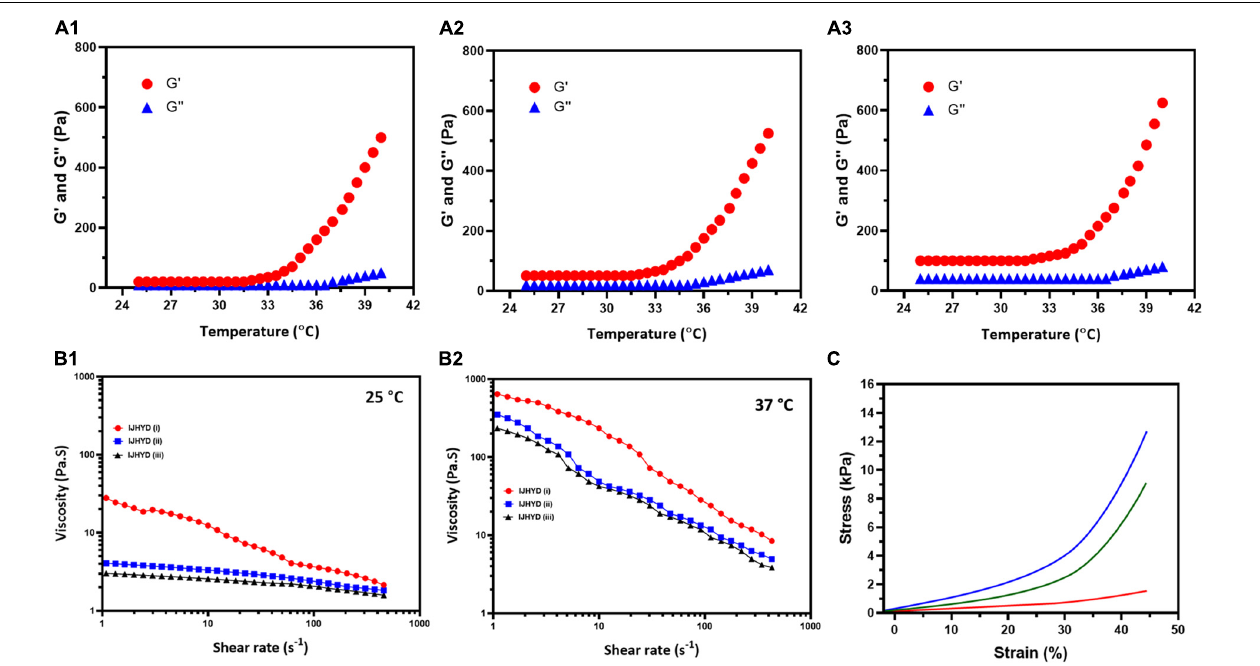
FIGURE 5 | Systematic observations of temperature dependent G (cid:48) and G (cid:48)(cid:48) functions for the (A 1 ) CS, (A 2 ) Mg/CSSF, and (A 3 ) Mg/CSSF hydrogel groups. (B 1 , 2 ) Viscosity vs. shear rate observations of prepared hydrogel groups at 25 and 37 ◦ C, respectively. (C) Stress–strain curve results of the hydrogel